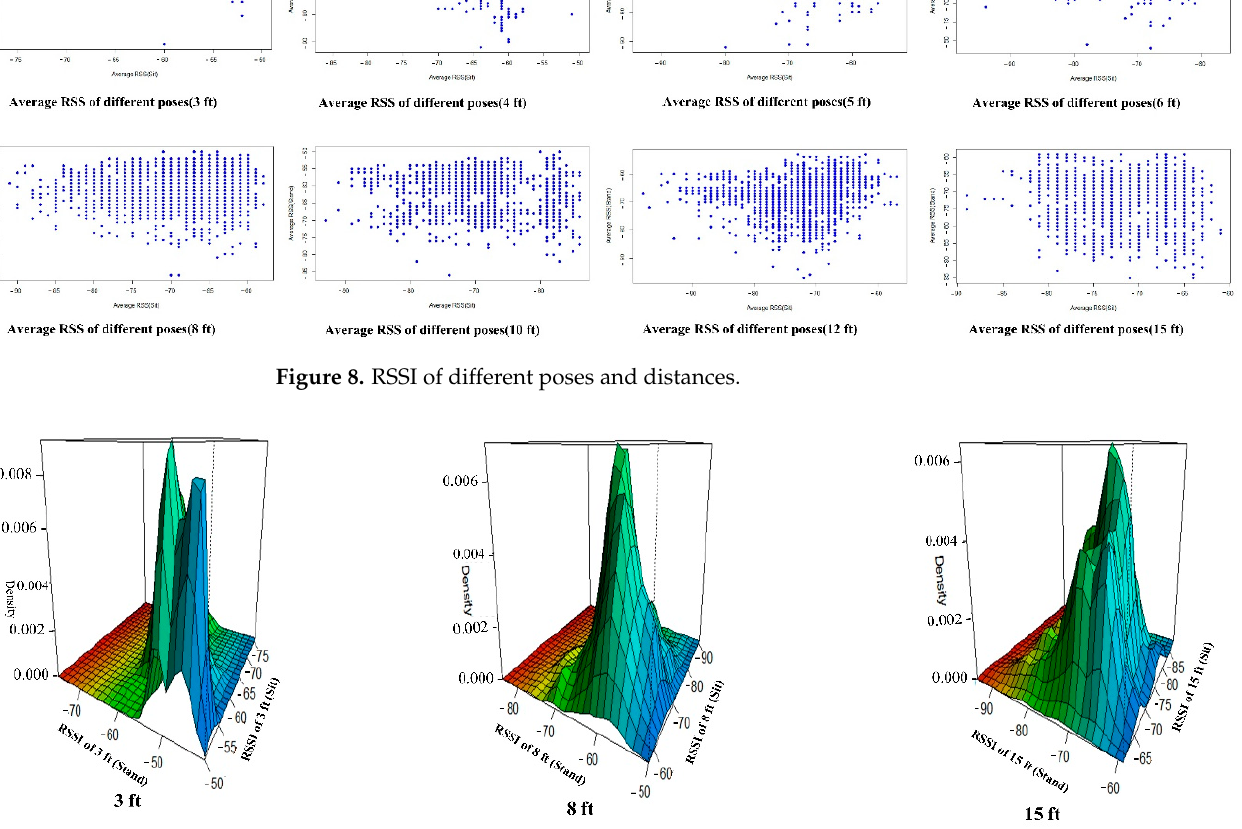
Figure 9. Three-dimensional density plots of RSSI with 3 ft, 8 ft, and 15 ft.